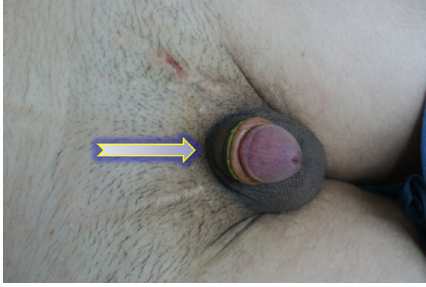
Figure 4. A plastic gasket (arrow) is present underneath the